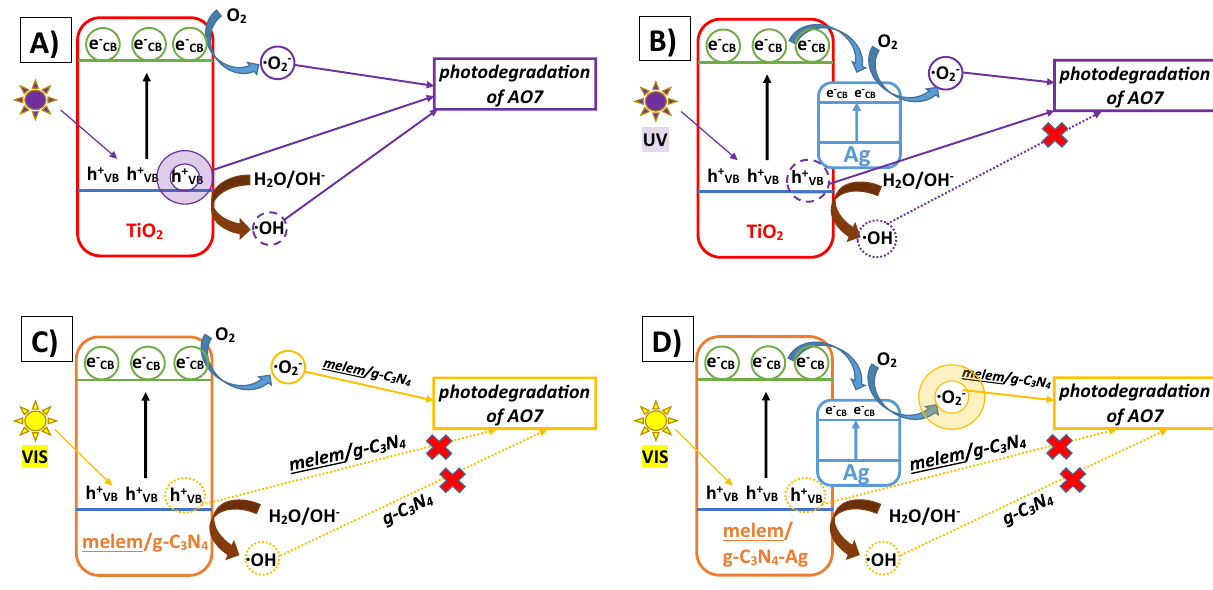
Figure 16. UV light induced photodegradation mechanism on ( A ) TiO 2 NPs and ( B ) TiO 2 -Ag NPs under; VIS light induced photodegradation mechanism on ( C ) melem/g-C 3 N 4 composites and ( D ) melem/g-C 3 N 4 -Ag